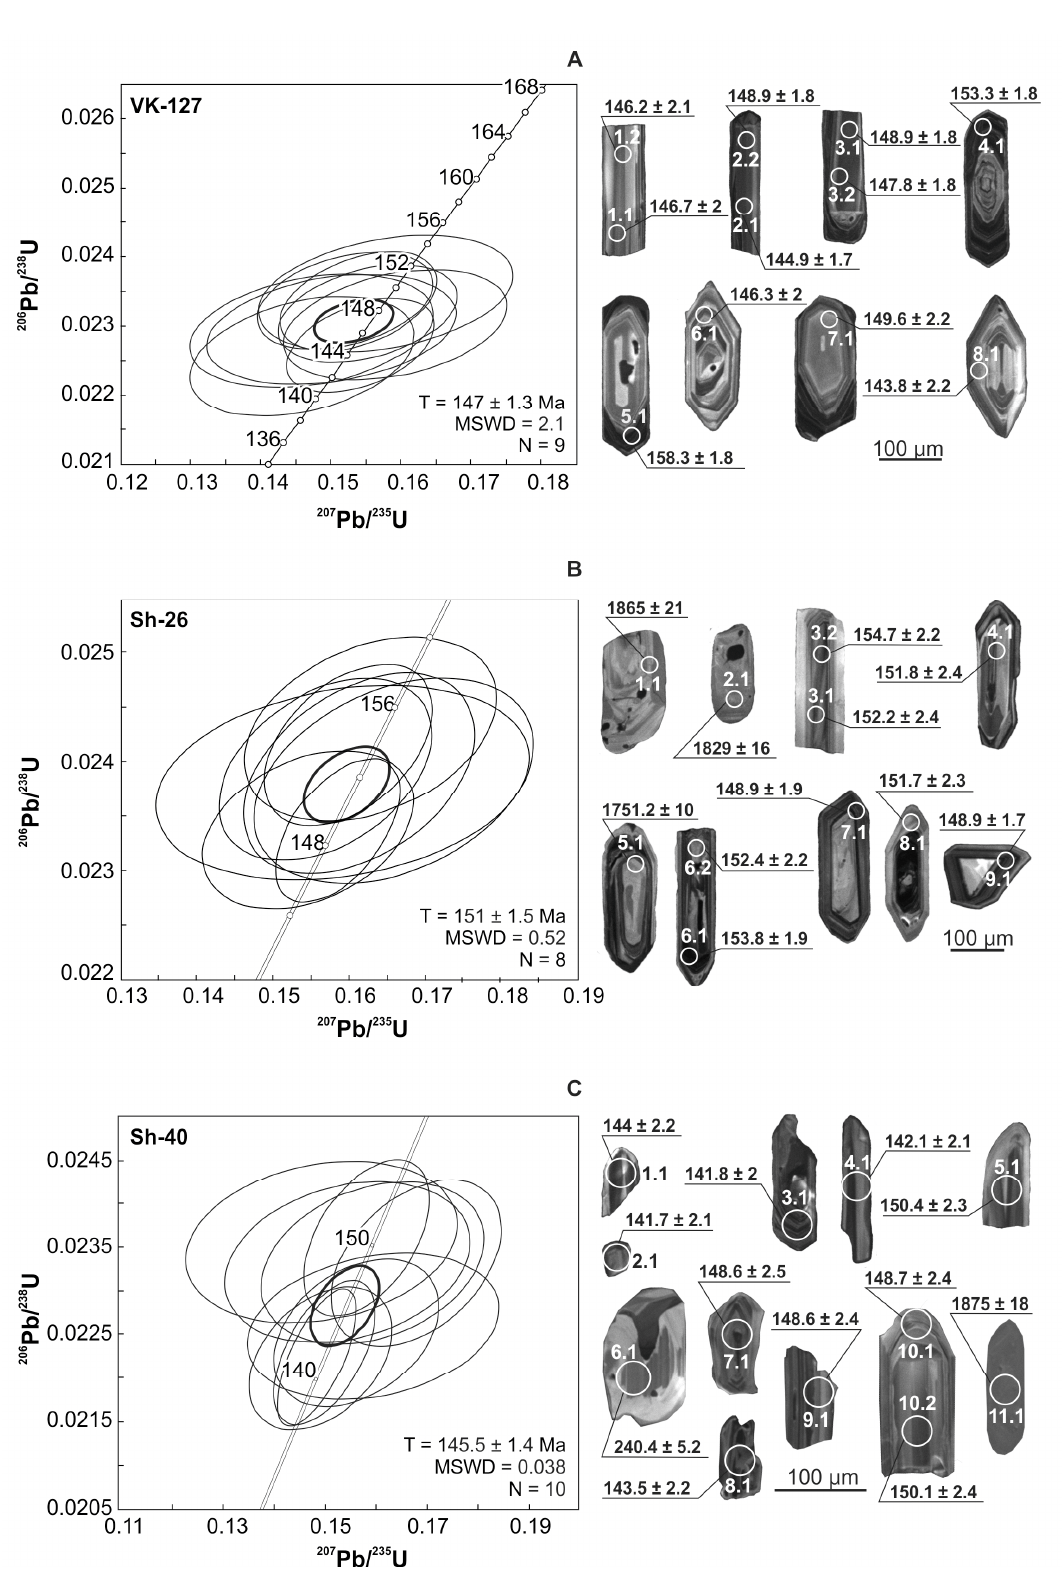
Figure 7. Concordia diagrams and cathodoluminescence (CL) images of zircons from dacite sample VK-127 ( A ); granodiorite sample Sh-26 ( B ); and trachyandesite sample Sh-40 ( C ) from the Vyun and Shumniy sites. Numbered circles on the grains denote analytical spots and correspond to the numbers in Table 5.